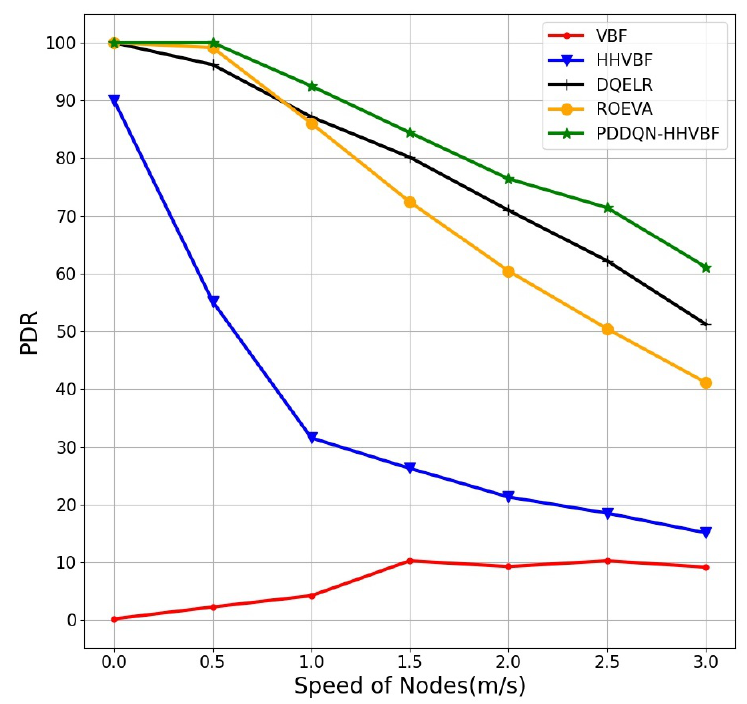
Figure 12. The PDR of VBF, HHVBF, DQELR, ROEVA, and PDDQN-HHVBF protocol in different speed of